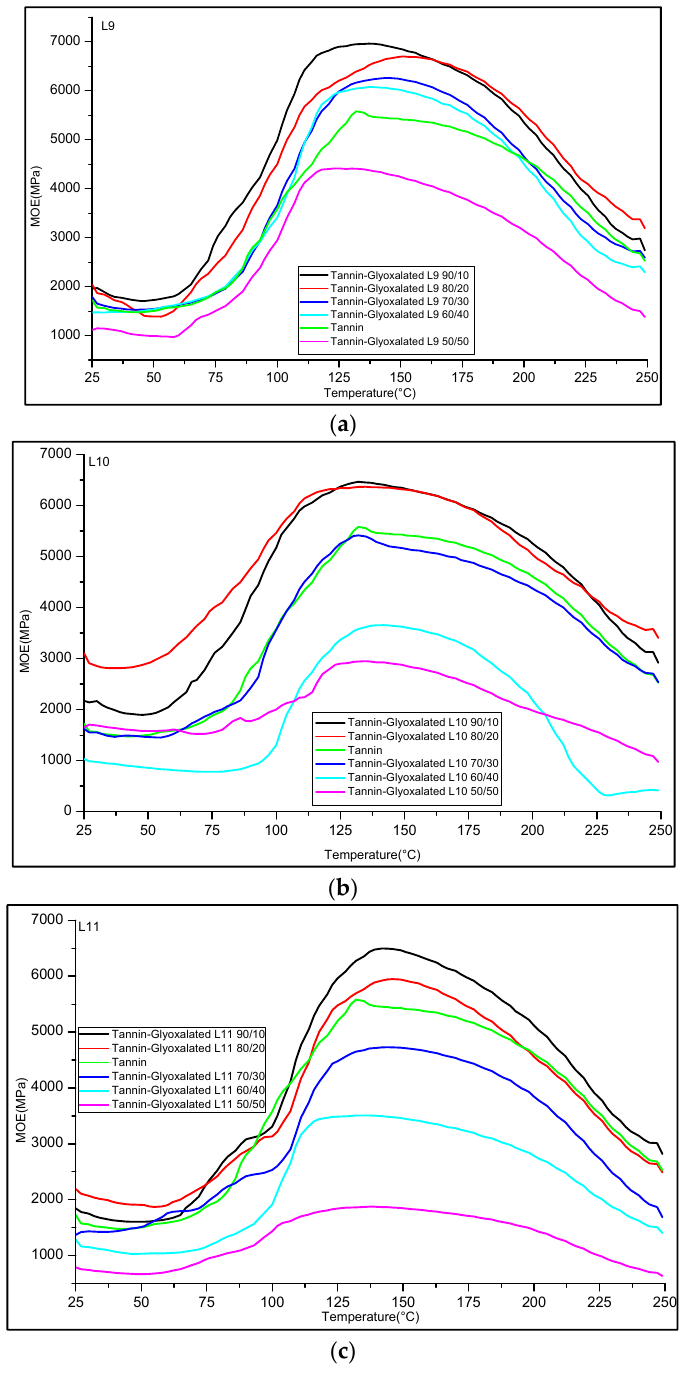
Figure 5. Comparison of thermo-mechanical analysis curing curves of wood joints bonded with lignin/tannins adhesives. Influence of the lignin content; ( a ) L9; ( b ) L10; ( c ) L11. The tannin/lignin based formulations were tested for application to wood panels. One-layer particleboards were produced at the lab scale and the internal bond strengths (IB) were determined.